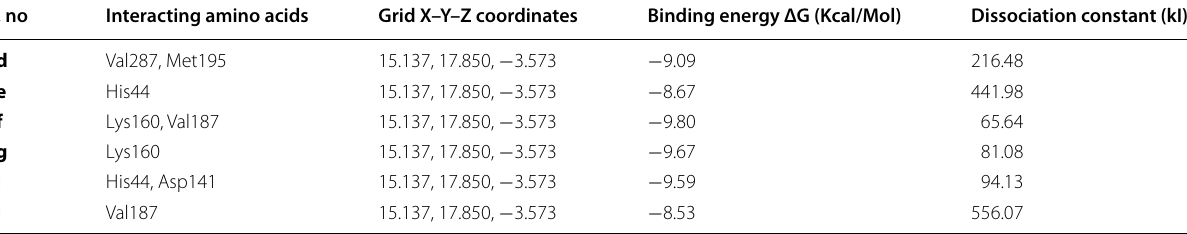
Table 4 Interactions of compounds (5d, 5e, 5f, 5g, 5i, 5l) with crystal structure of pantothenate synthetase in complex with (PDB id: